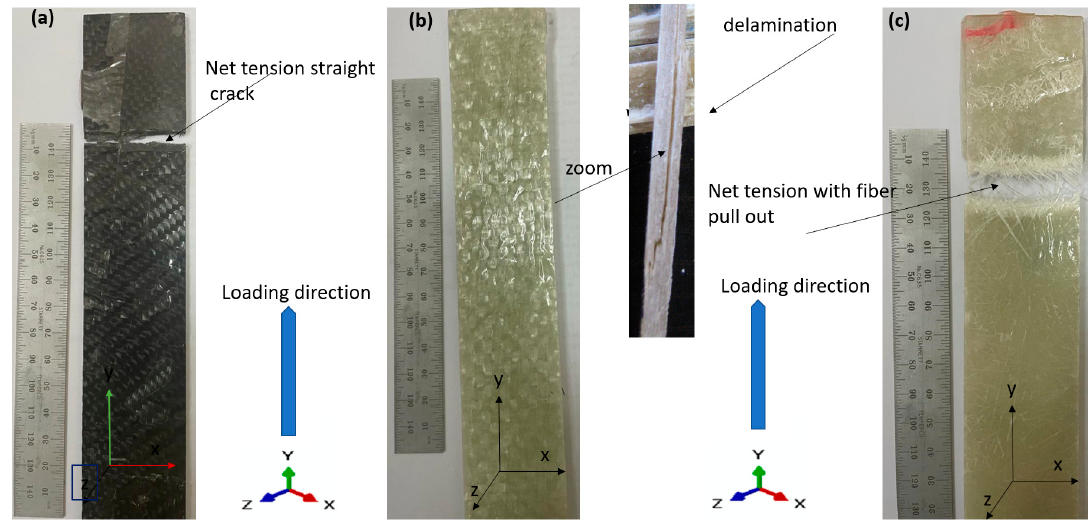
Figure 9. Modes of failure ( a ) CFRP, ( b ) GFRP-W and ( c ) GFRP-R.